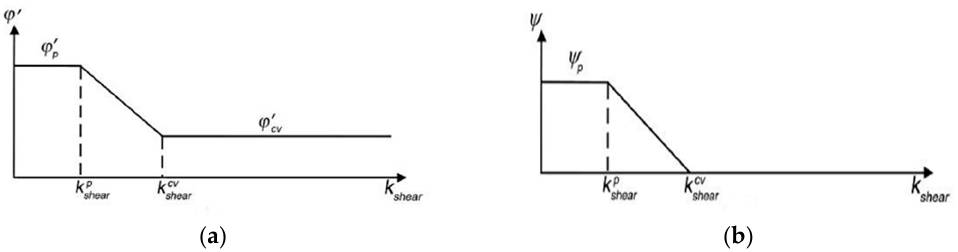
Figure 3. Variation of the effective friction angle and dilation angle with the accumulated deviatoric plastic strain: ( a ) φ (cid:48) − k shear relationship; ( b ) Ψ (cid:48) − k shear